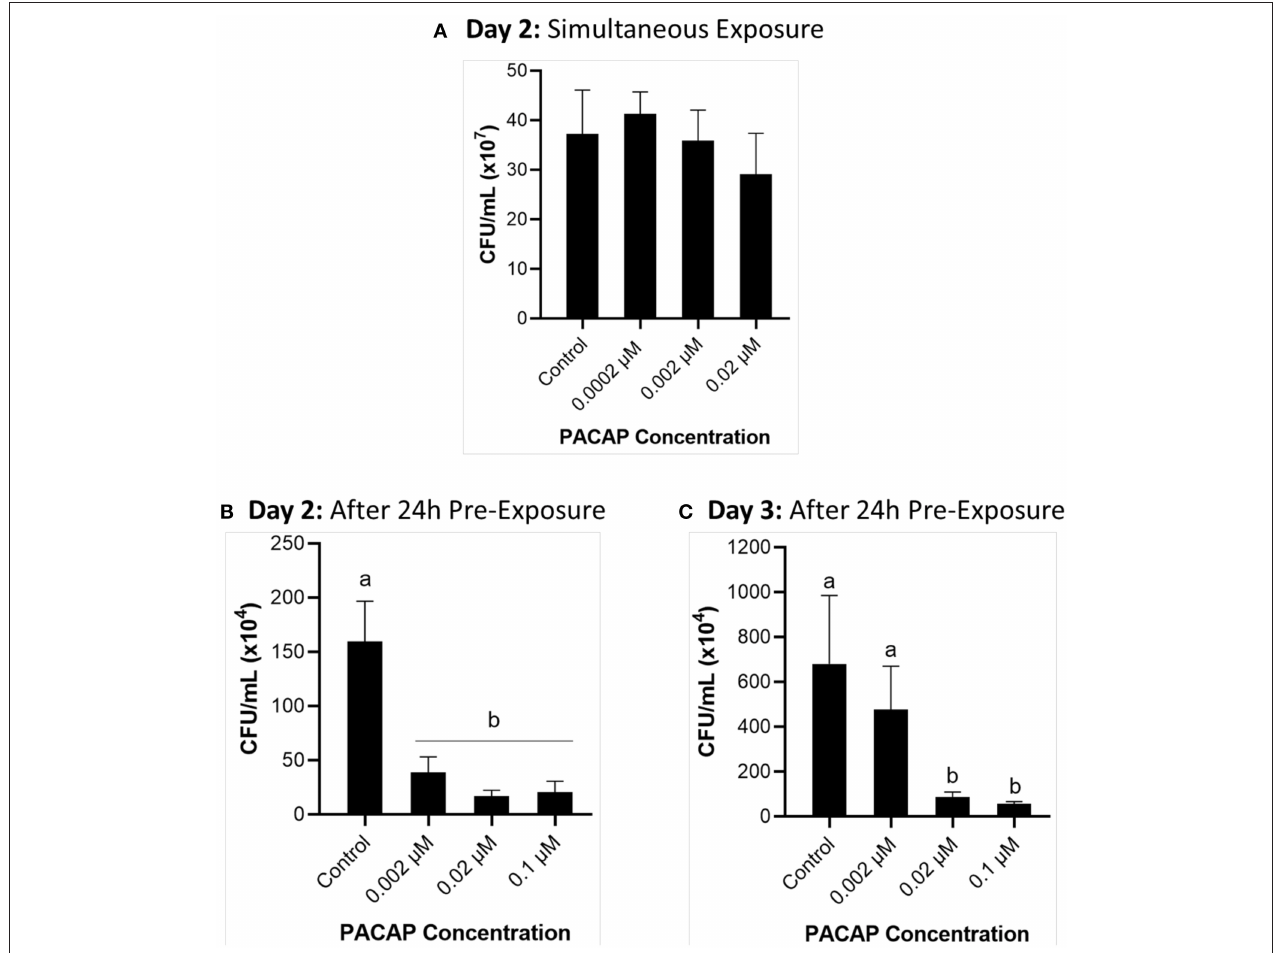
FIGURE 3 | Quantification of F. psychrophilum by standard plate count (SPC) of cell culture media during live infection (MOI of 0.7-1.3) of PACAP-treated RTS11. RTS11 was exposed to live F. psychrophilum either alone or in combination with C. gariepinus PACAP-38 concentrations (0.0002–0.02 µ M) and CFU/mL was calculated on day 3 (A) . RTS11 pre-treated with PACAP-38 concentrations (0.002–0.1 µ M) 24h before exposure to live F. psychrophilum and the CFU/mL was calculated on day 2 post-infection (B) and day 3 post-infection (C) . Each panel represents the results of three independent experiments where a p < 0.05 was considered to be significantly different when compared to the no PACAP control (i.e., RTS11 exposed to only live F. psychrophilum ). All vertical error bars represent the SD. Lowercase letters denote significant differences at p <